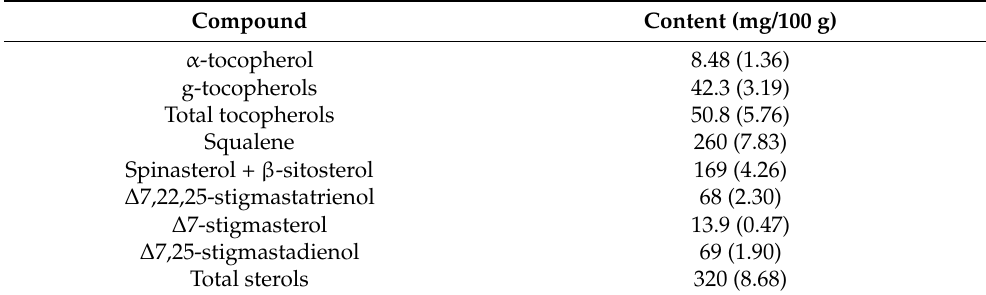
Figure 4. SEM images of encapsulated pumpkin oil in carbohydrate shells: maltodextrin (M), wheat starch (WS), rice starch (RS), maize starch (MS), lactose (L) and trehalose (T). Table 4. Bioactive unsaponifiable compounds in native pumpkin